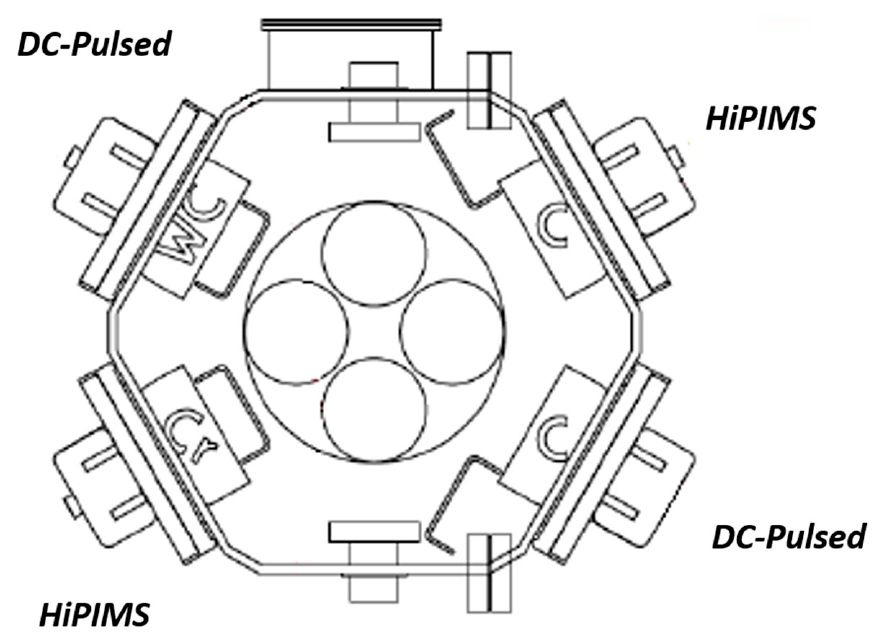
Figure 1. Process chamber horizontal cross-section.